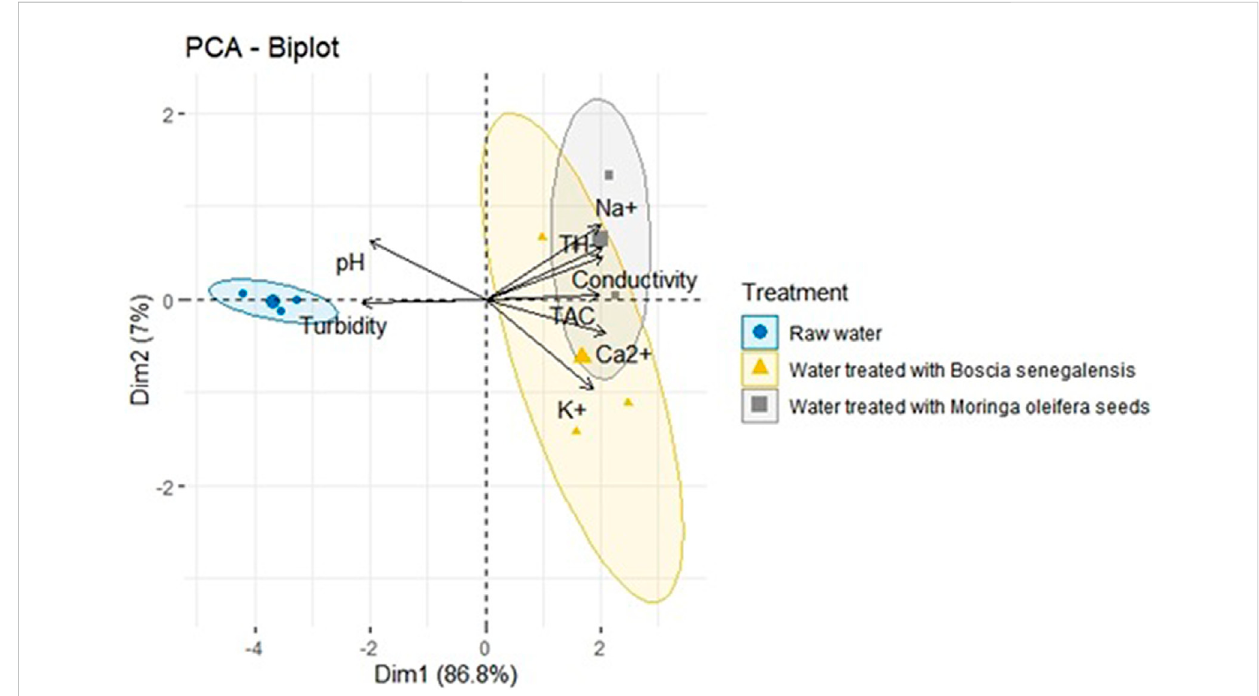
FIGURE 11 Principal component analysis of physicochemical parameters of water treated with Moringa oleifera and Boscia senegalensis seeds.